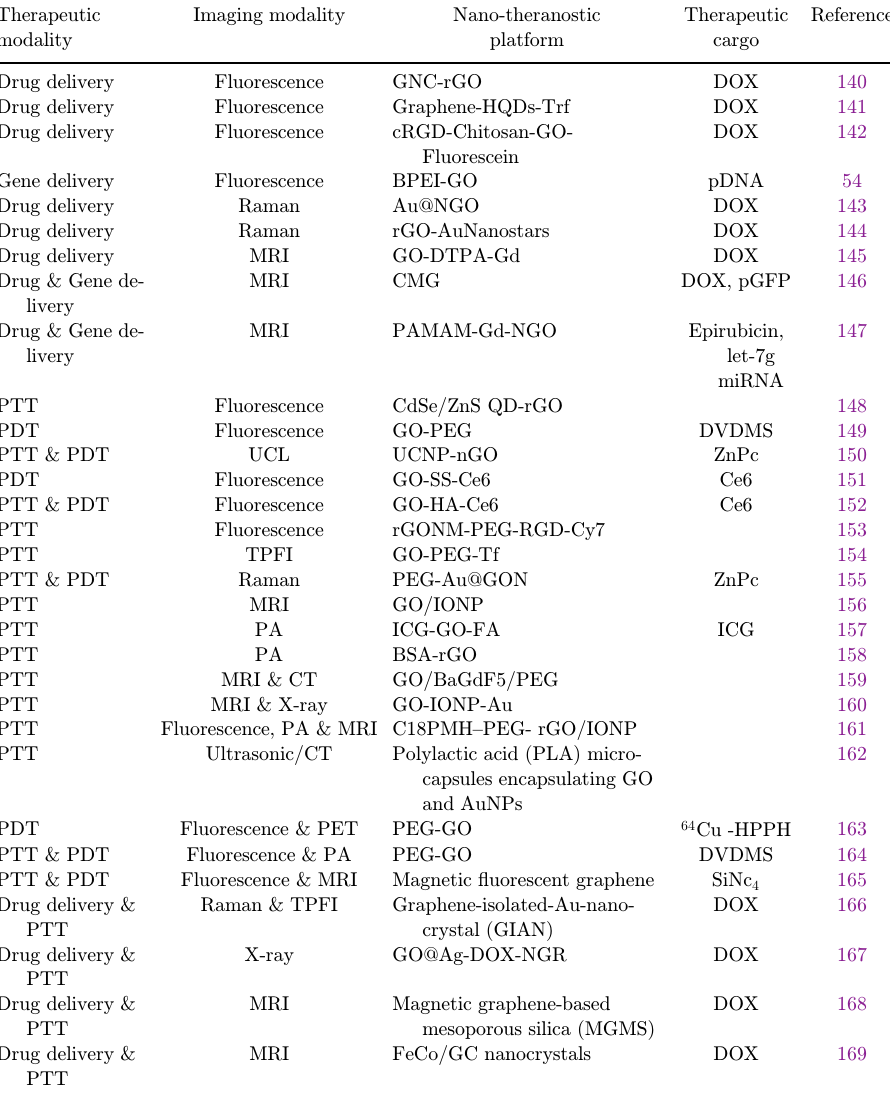
Table 6. Summary of graphene-based nano-theranostic